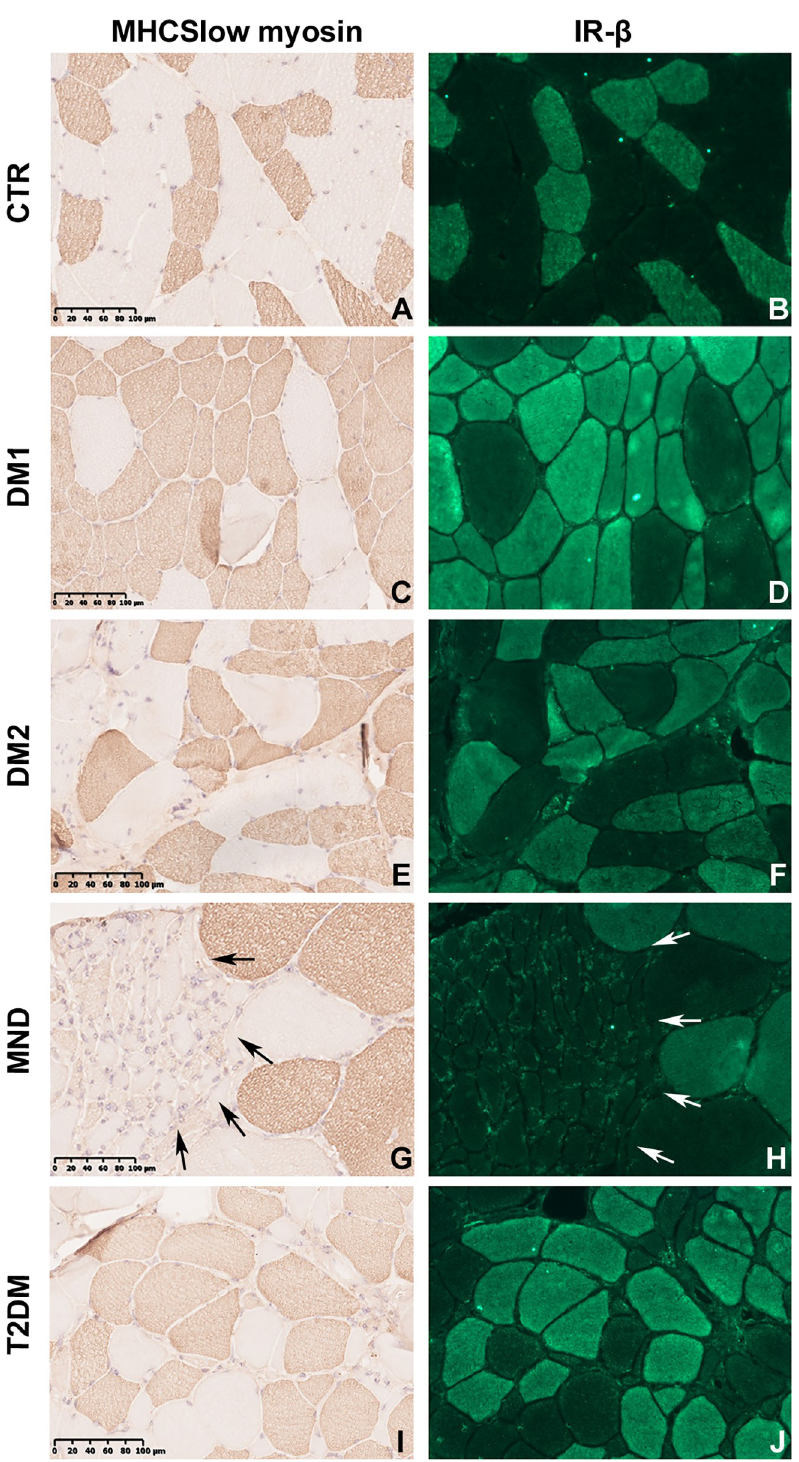
Fig 1. MHCslow immunostaining and insulin receptor immunolocalization. Representative microscopy images from serial skeletal muscle sections stained with antibodies against MHCslow (brown) or IR (green). Images are representative of 1 CTR (A, B) , 1 DM1 (C, D) , 1 DM2 (E, F) , 1 MND (G, H) and 1 T2DM (I, J) patient. In (g) and (h) arrows define type 2 fiber grouping. Original magnification 200x.